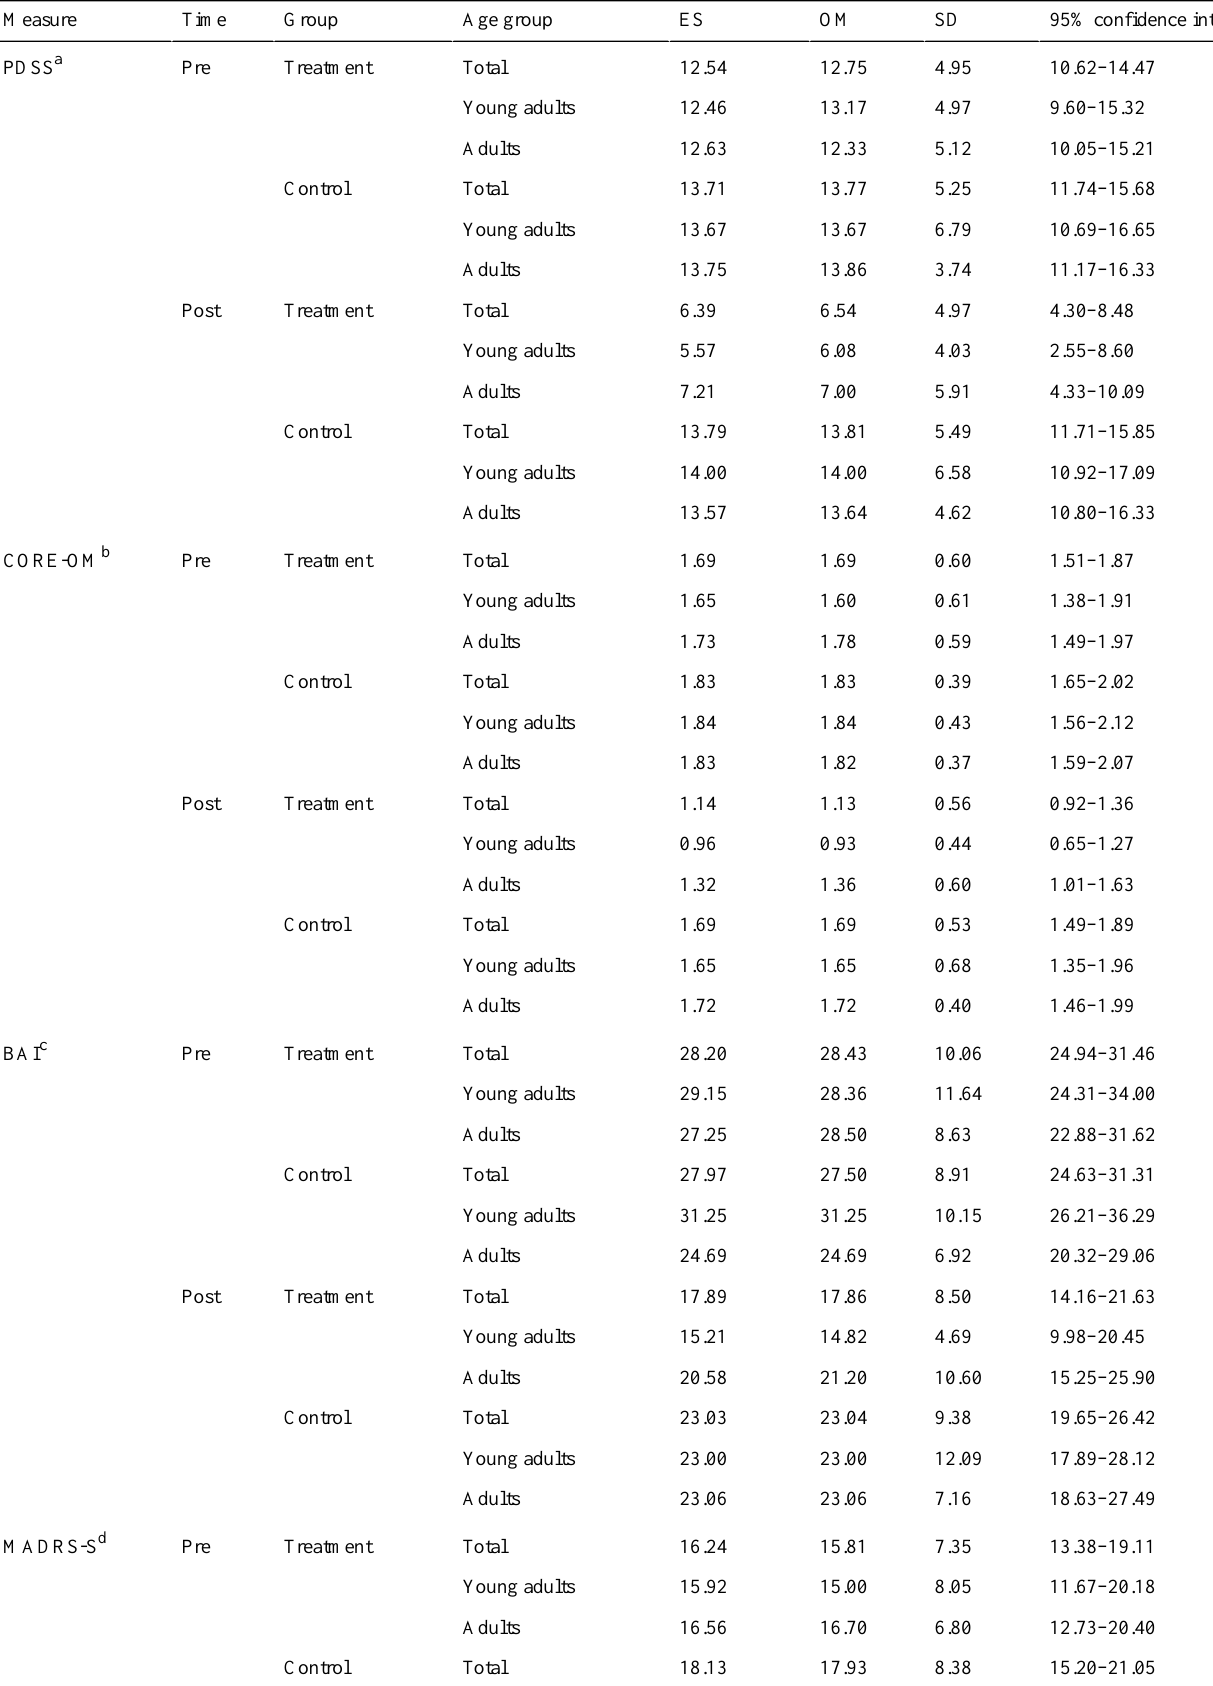
Table 3. Immediate results with intention-to-treat analysis using mixed-effect model estimated means (ES) (n = 57), observed means (OM) (n = 50 for the main outcome measure a and n = 49 for the secondary outcome measures), and standard deviation (observed) at pre- and posttreatment for the measures of panic, anxiety, depression, and quality of